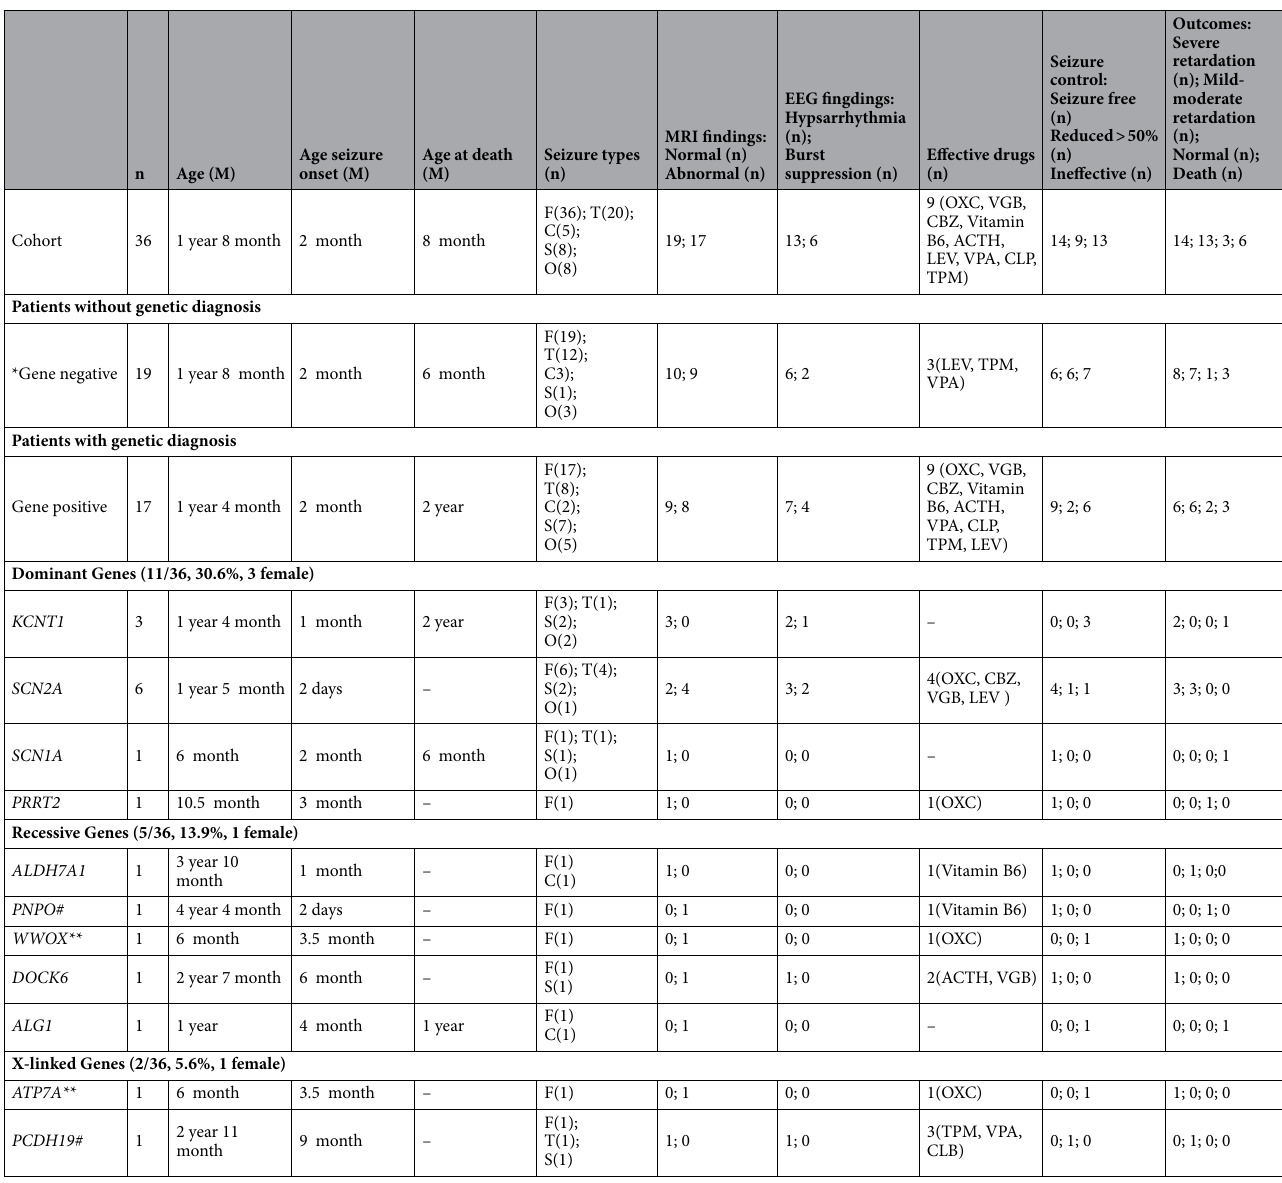
Table 3. Phenotype-genotype data of 36 patients with MMPSI. ACTH, Adrenocorticotropic Hormone; C, clonic; CLP, Clonazepam; CBZ, Carbamazepine; F, focal; m, months; M, median; MMPSI, Malignant migrating partial seizures of infancyn, number; LEV, Levetiracetam; O, other (includes tonic–clonic, spasms and others); OXC, Oxcarbazepine; S, spasms; T, tonic; TPM, Topiramate; VGB, Vigabatrin; VPA, Valproic Acid; y, year; *: Gene negative patients include those who have had a genetic test and the result was negative and those who have not been tested; **: one patient has two genetic mutations.; #: The mutant was